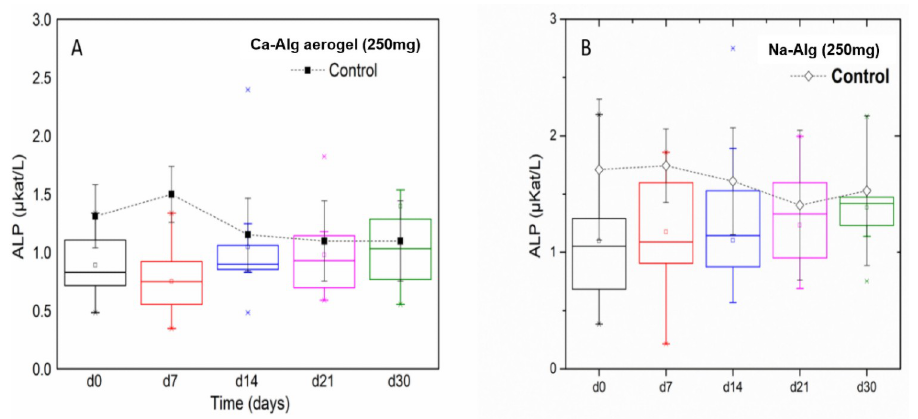
Fig 5. Box-plot for ALP test that was done for the 250 mg Ca-Alg aerogels (A) and Na-Alg (B) during a long-term experiment. The dotted lines in all the panels represent the ALP values for all the control groups.